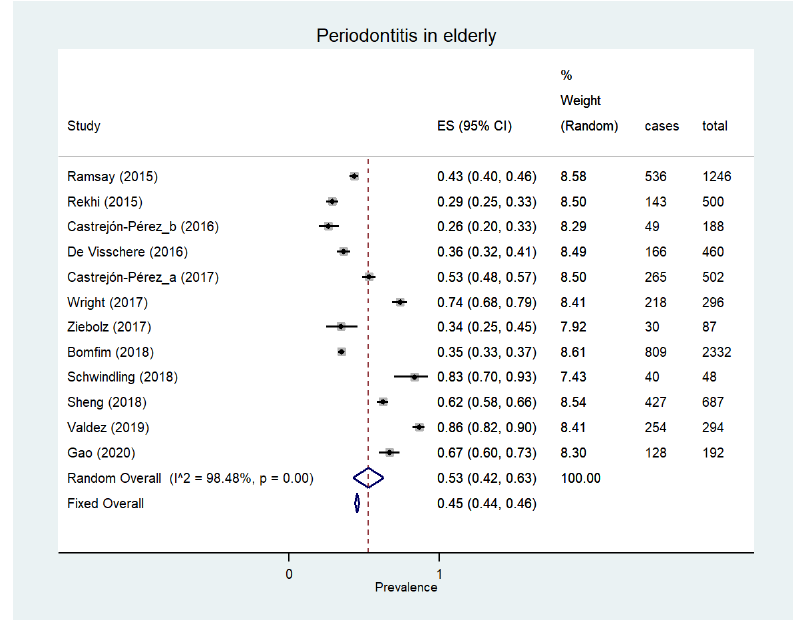
Figure 4. Periodontitis in the elderly.